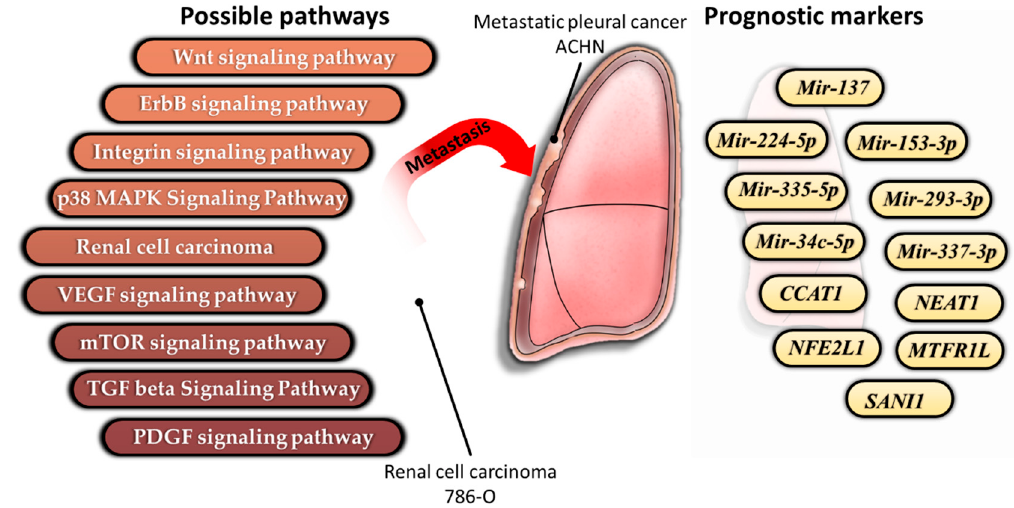
Figure 5. Schematic summary of the identified molecules in metastatic RCC cells.